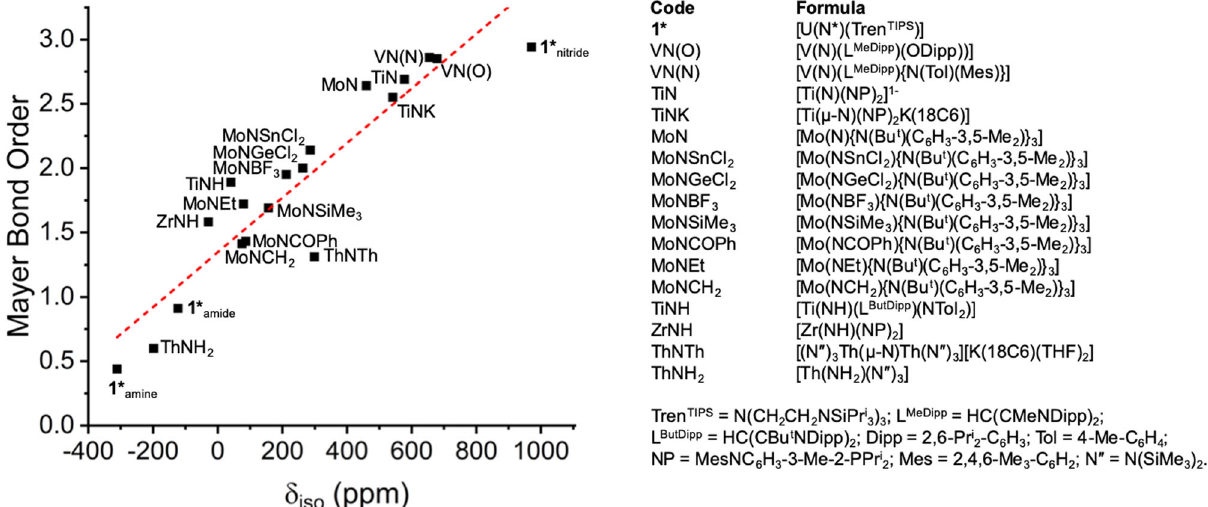
Fig. 6 Correlation of experimental 15 N δ iso data with computed Mayer bond orders. Linear regression: Mayer bond order = (0.0019 × δ iso (exp)) + 1.3461, R 2 =